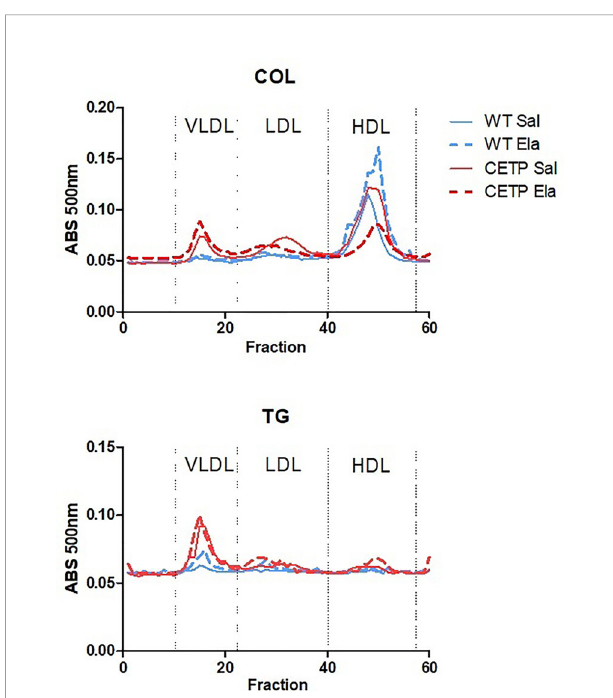
FIGURE 13 | Plasma lipoprotein analysis by high-performance liquid chromatography (FPLC) in WT and huCETP mice after elastase-induced emphysema (ELA) or saline (SAL). Average of two to three pools (n = 4).